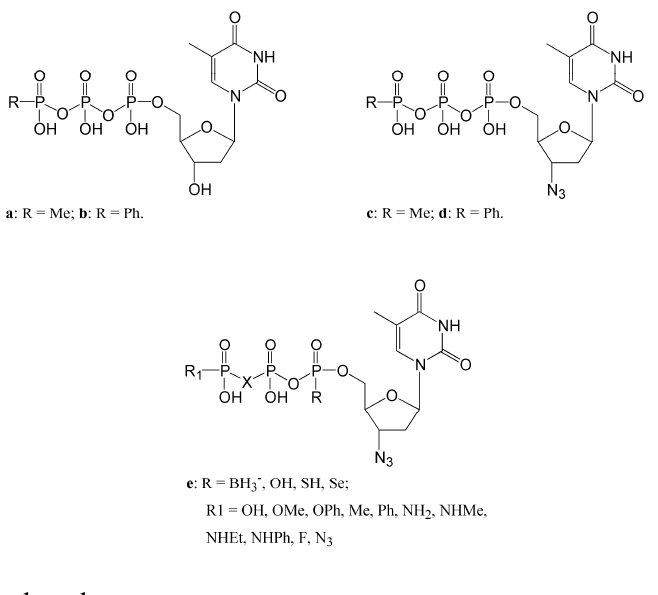
Figure 3. Structures of nucleoside triphosphate analogs modi fi ed at the β and/or γ -phosphate.